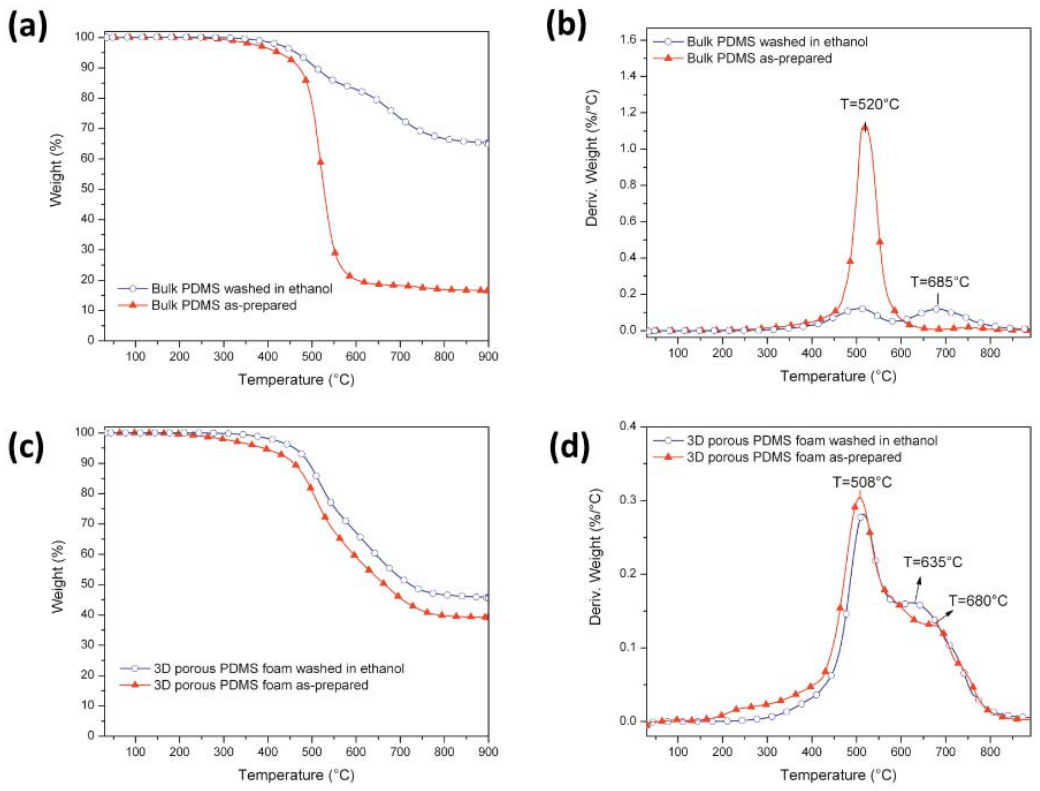
Figure 3. TG and DTG curves under N 2 of bulk PDMS ( a , b ) and 3D porous PDMS foam ( c , d ) before and after washing in ethanol.